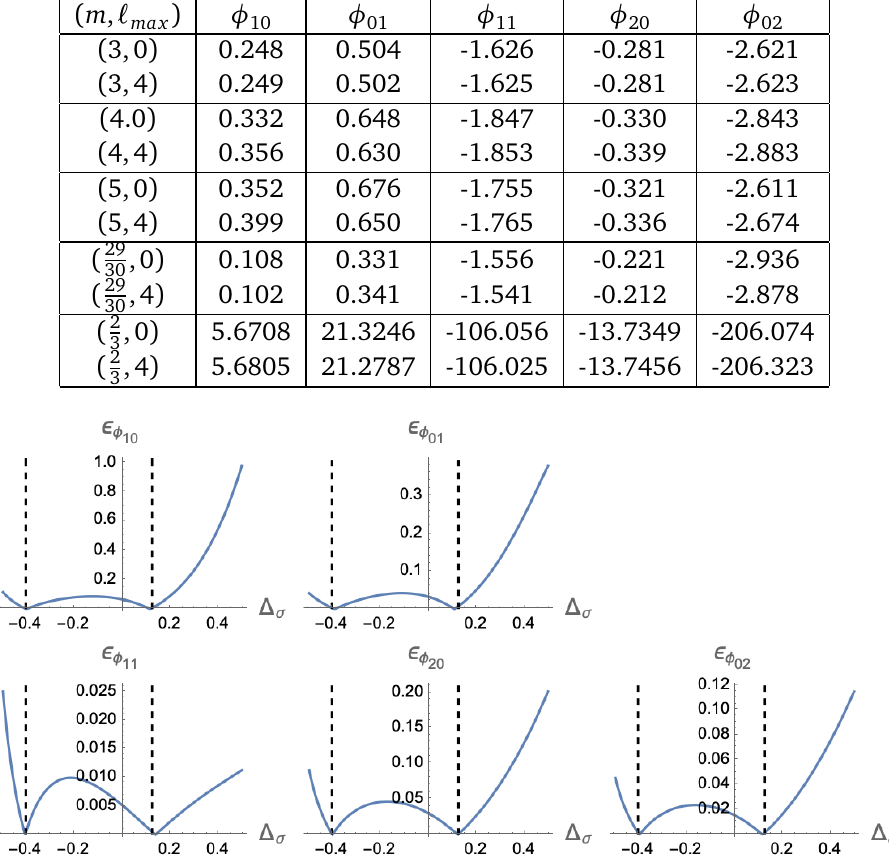
Figure 3: Fractional absolute error vs ∆ σ . The black dashed lines indicate the Ising model and Yang-Lee